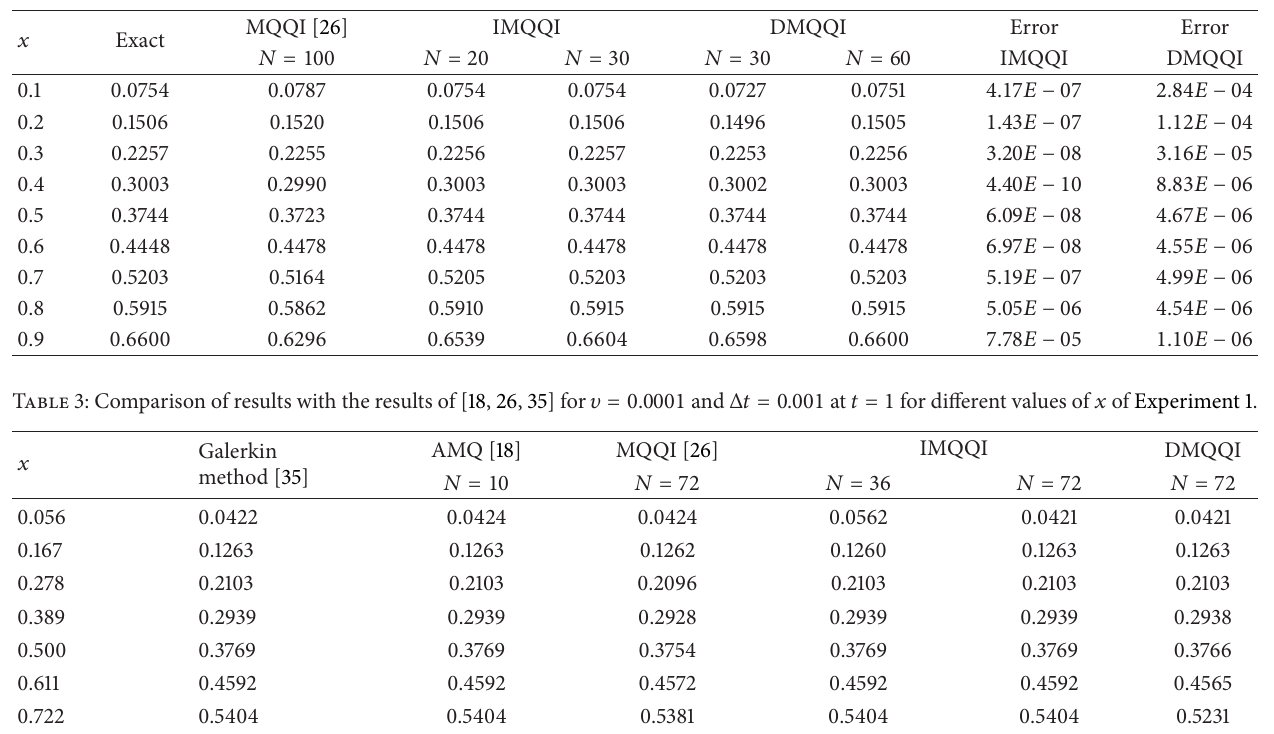
Table 2: Comparison of results with the exact solution and the results in [26] of 𝜐 = 0.01 with Δ𝑡 = 0.00 1 at 𝑡 = 1 for different values of 𝑥 of Experiment 1.